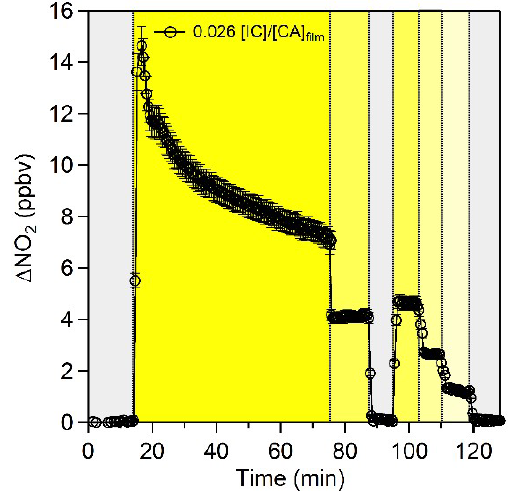
Figure 2. NO 2 profile for a 0.025MIC bulk solution, whose con- centration increases to ∼ 0.2M of IC in the film due to the citric acid hygroscopic properties. The gray shaded areas indicate peri- ods where NO was exposed in the dark. The yellow shaded ar- eas indicates the period of irradiation; the decrease in the inten- sity of yellow represents 2.26 × 10 16 , 1.47 × 10 16 , 1.14 × 10 16 and 3.94 × 10 15 photonscm − 2 s − 1 for seven, five, three and one lamp, respectively. This time series clearly indicates the light dependence production of HO 2 radicals from the photosensitization of IC in a CA